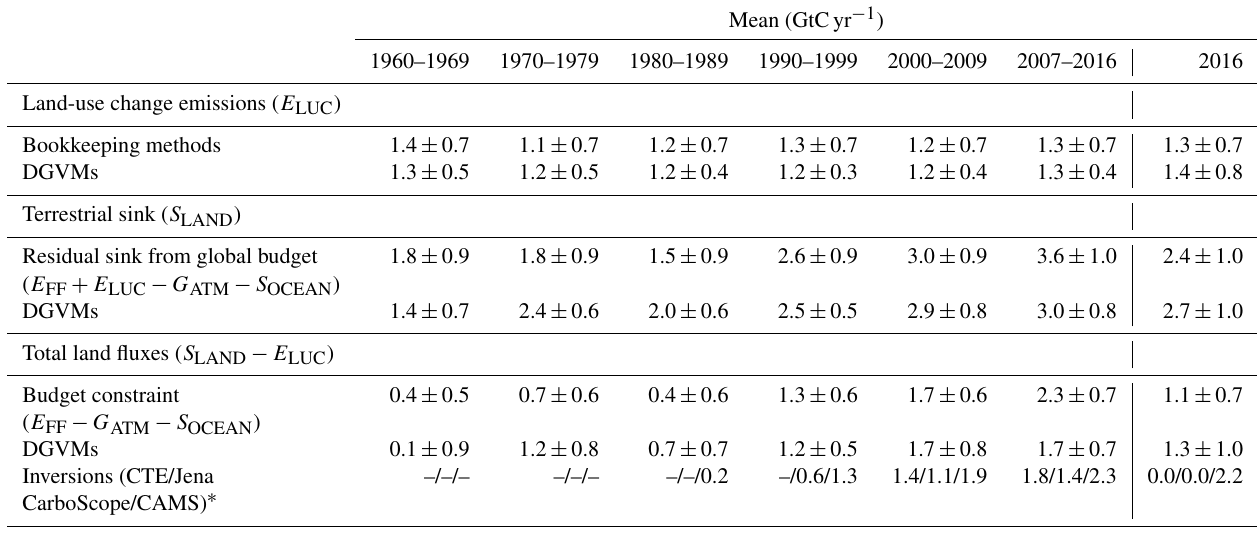
Table 5. Comparison of results from the bookkeeping method and budget residuals with results from the DGVMs and inverse estimates for different periods, last decade, and last year available. All values are in GtCyr − 1 . The DGVM uncertainties represent ± 1 σ of the decadal or annual (for 2016 only) estimates from the individual DGVMs; for the inverse models all three results are given where